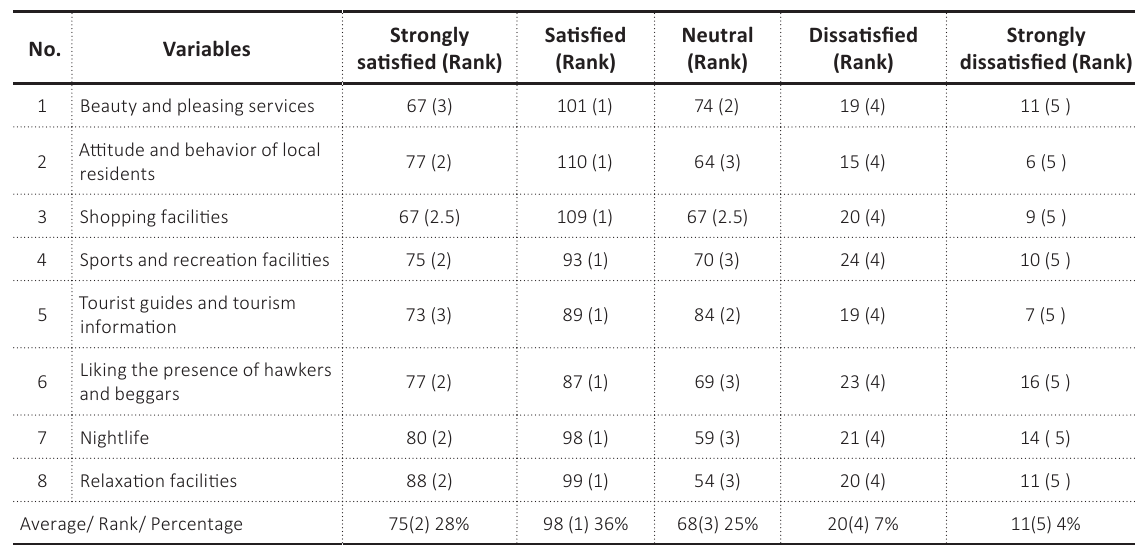
Table A7. Tourists’ responses about other services, facilities and related factors of Saudi Arabian tourism